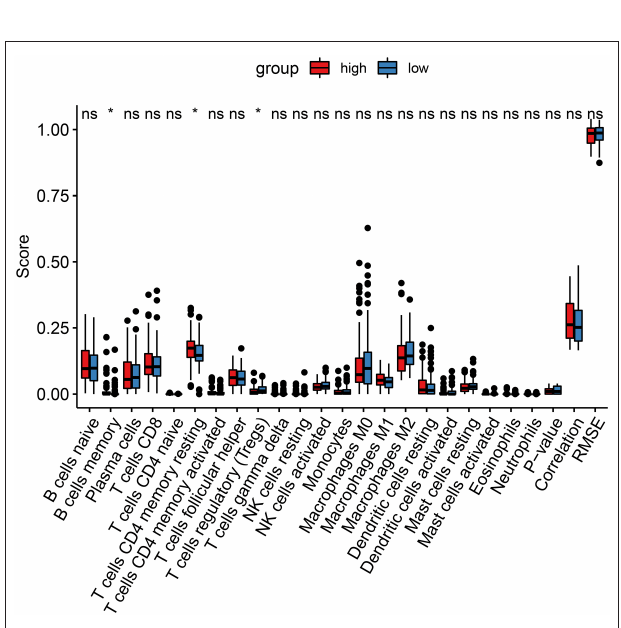
FIGURE 6 | CIBERSORT identifies the association between the ferroptosis-related model and immune cell infiltration in thyroid cancer. Red, the high-risk group and blue, low-risk group. Ns, not significant; * p < 0.05.